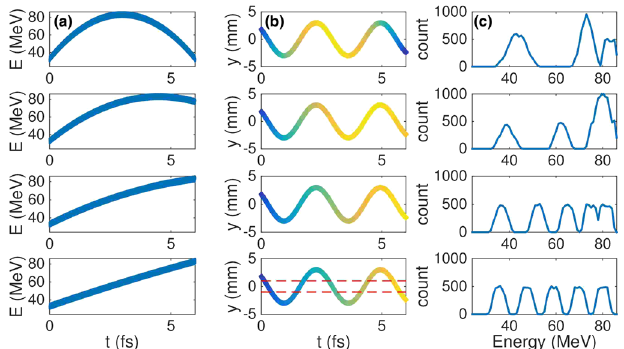
FIG. 3. The left column (a) shows the longitudinal phase space of electron bunches with different energy chirps. The middle column (b) shows the corresponding bunch modulated by the laser, where the bunch length is 6 fs and the laser wavelength is 0 . 8 μ m. The corresponding energy of the electron increases as the color changes from blue to yellow. The amplitude of the modulation is 3 mm, and the width of the slit is 2 mm, as shown by the dashed lines in the last subfigure in column (b). The corresponding energy spectrums measured with the presence of the slit are shown in the right column (c). FIG. 4. Experiment